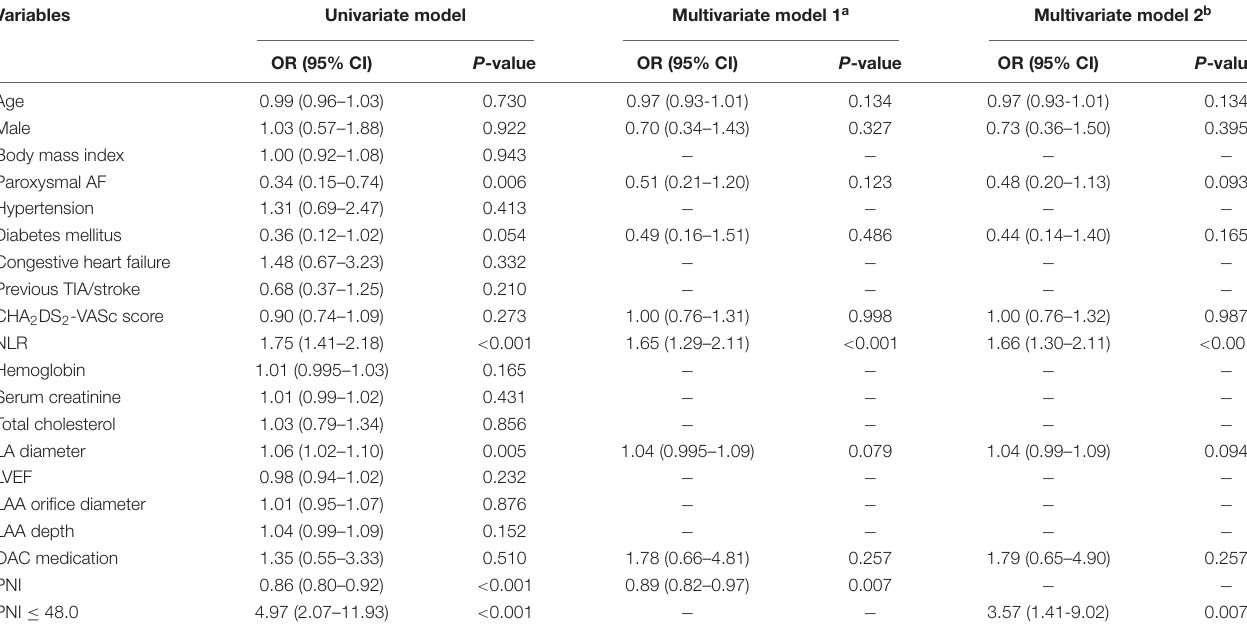
TABLE 2 | Univariate and multivariate logistic regression models to identify the in predictors of LAAT/dense SEC.